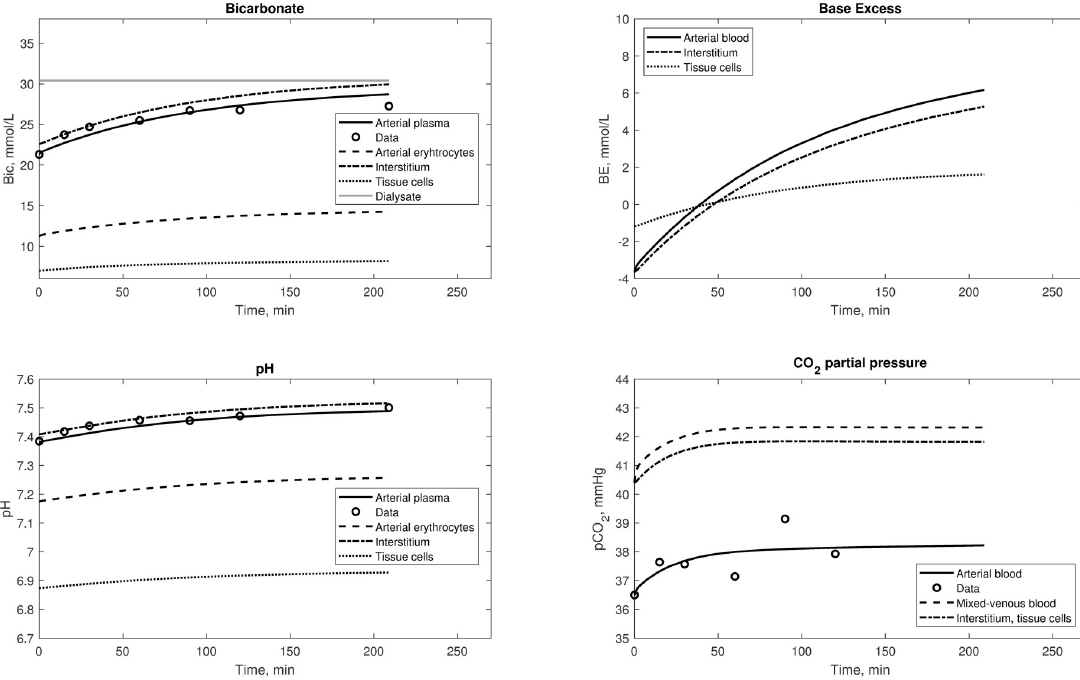
Fig 2. Simulations of several variables of the model, fitted to the data from the study by Sargent et al [26]. The dialysate concentration of bicarbonate was corrected for the Gibs-Donnan effect.